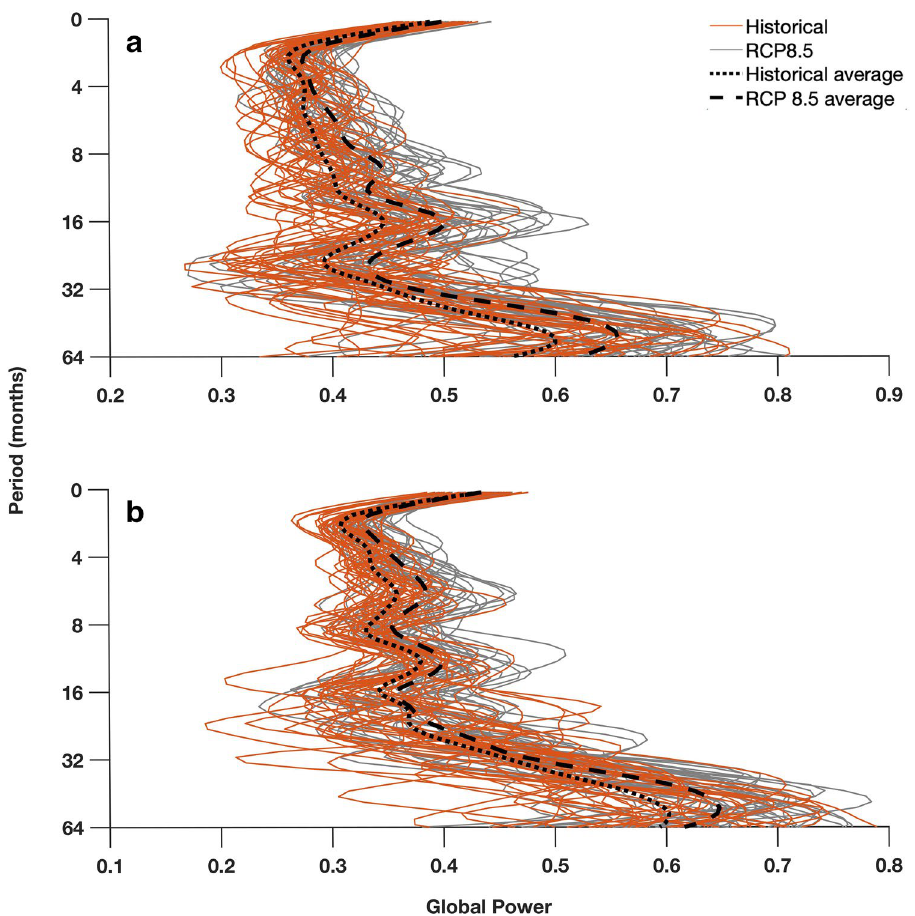
Figure 5. Global wavelet power (horizontal averaging in time) of the wavelet coherence of the Aleutian Low SLP in the Kuroshio Extension ( a ) net heat flux and ( b ) SST for all 36 ensemble members of CESM1-LENS in the past (orange) and in the future (grey). Black dotted and dashed lines represent the ensemble averages of the historical and RCP8.5 future runs respectively. The periods over 64 months were eliminated due to the influence of the edge effects of the wavelet transform which may produce spurious